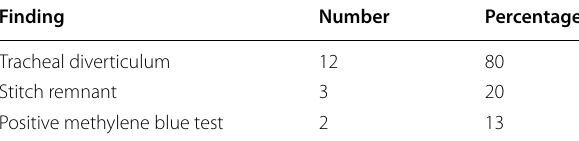
Table 3 Findings at the site of the ligated fistula